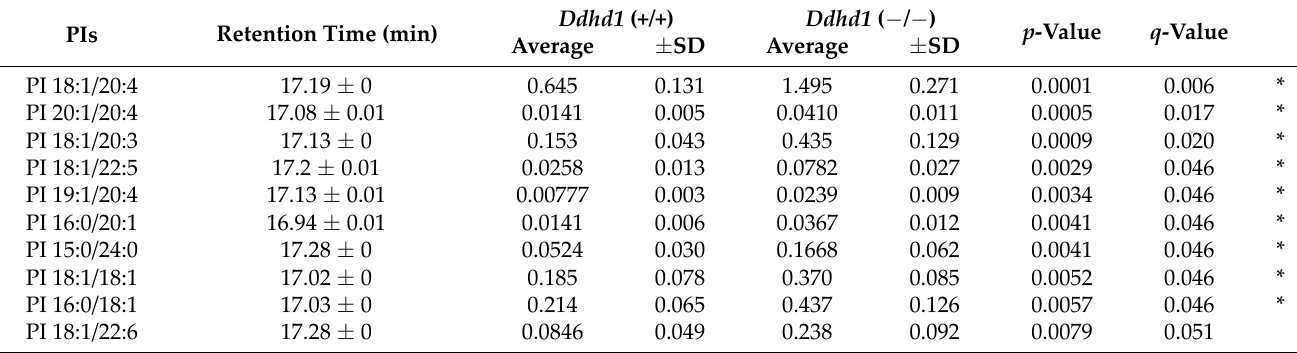
Table 2. PIs identified from mice